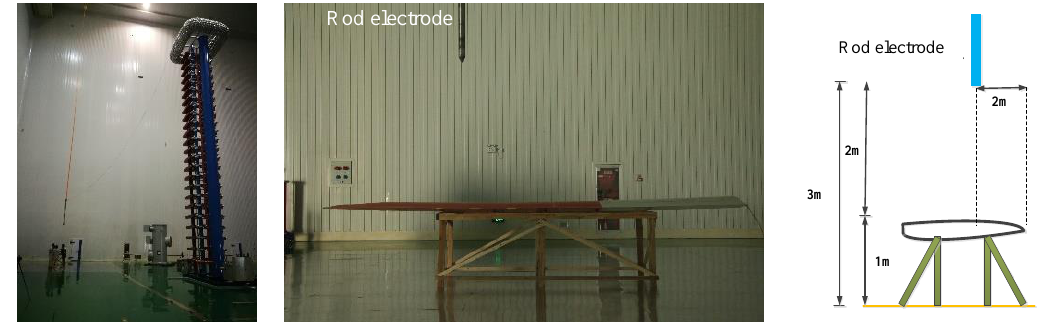
Figure 3. Experimental geometric model.